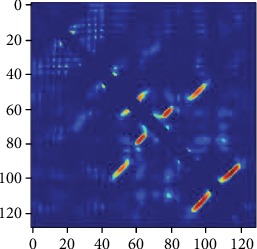
Protein contact map.